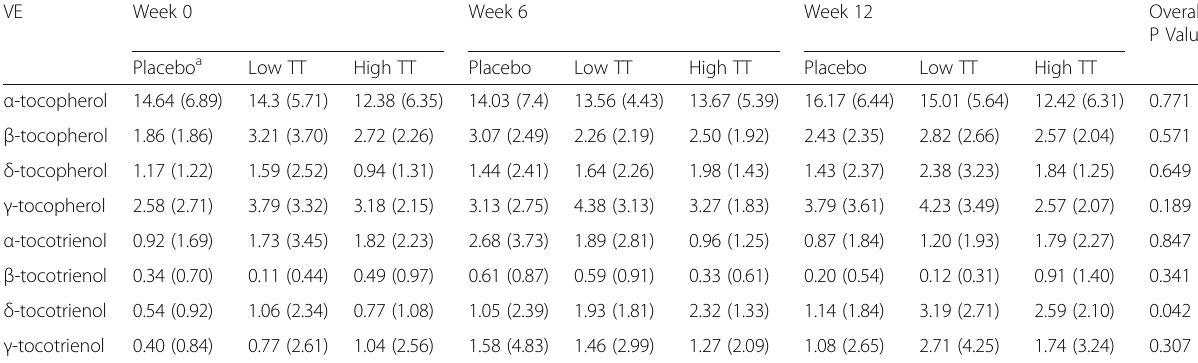
Table 2 Concentrations ( μ mol/L) of tocopherols and tocotrienols in various treatment groups at weeks 0, 6 and 12